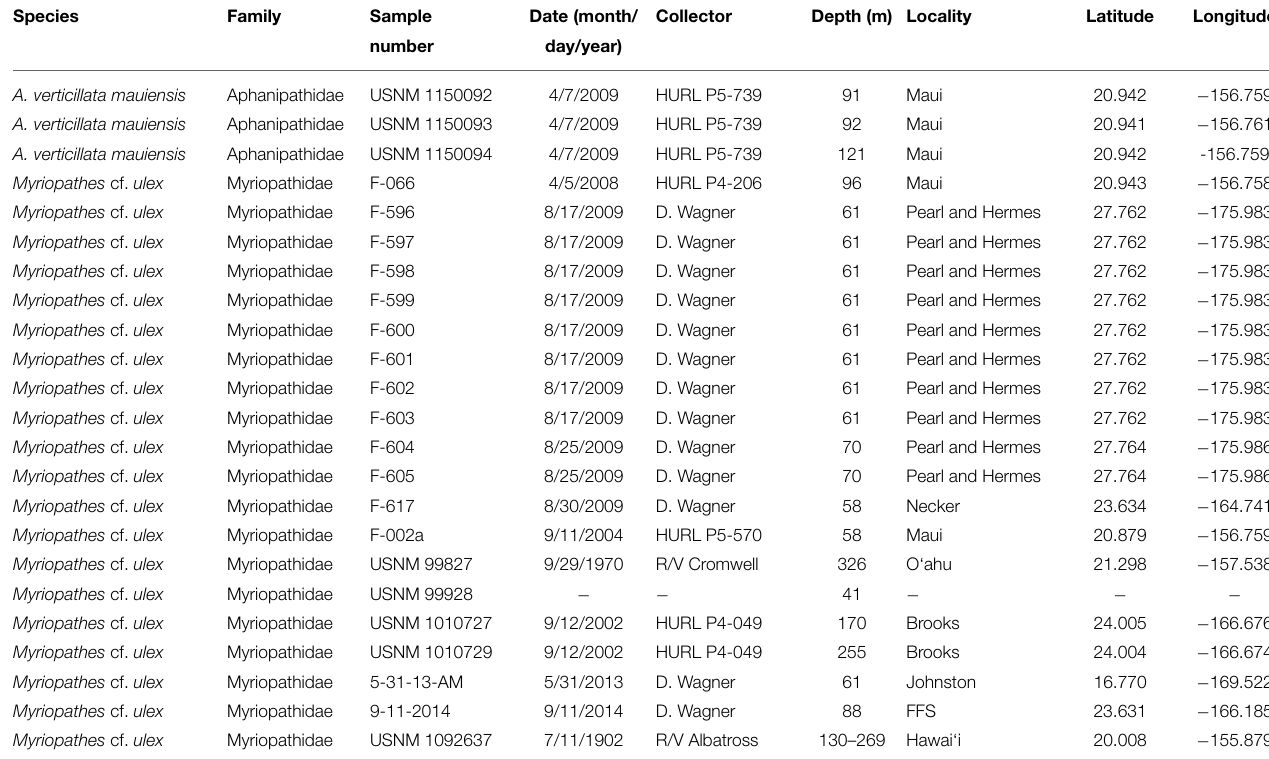
Figure 5); Antipathes dichotoma : (Pyle and Chave, 1994, p.